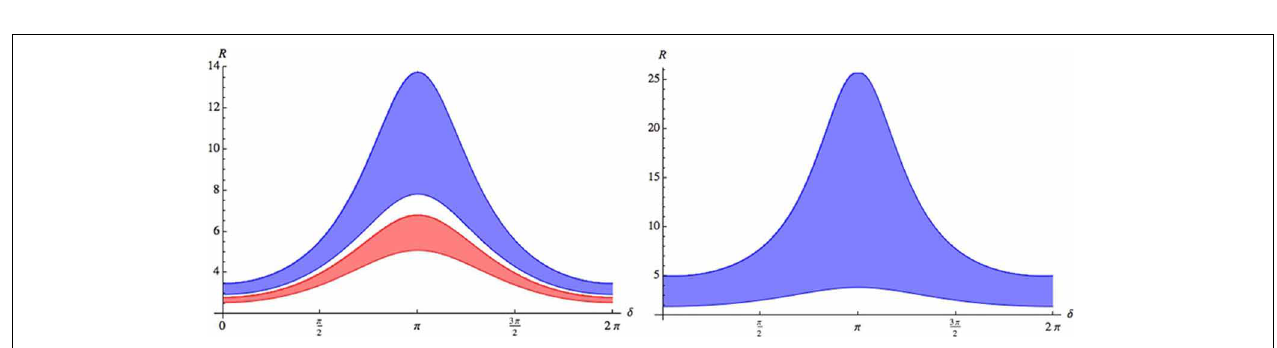
lower band) and another one for θ 23 in the 2nd octant (blue higher band). One can see that values of θ 23 in the 2nd octant give a stronger